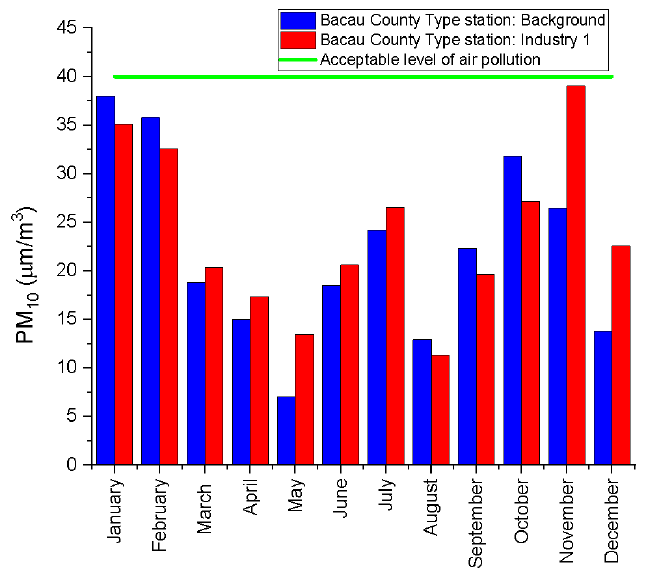
Figure 15. Average PM10 concentration in individual months of 2020.